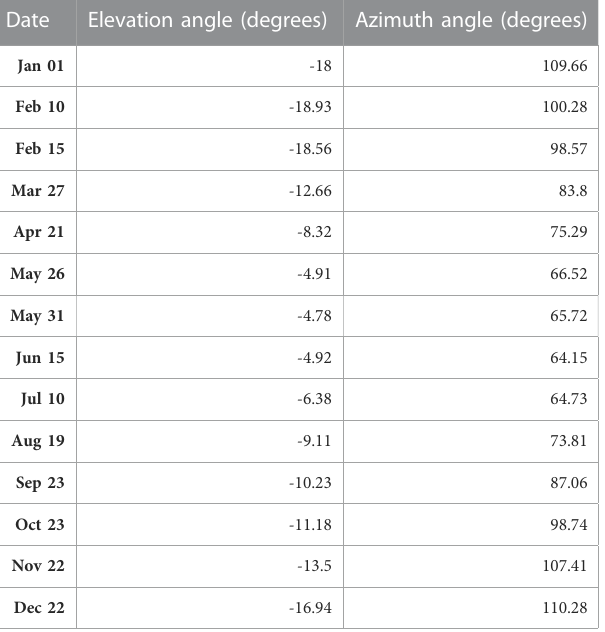
TABLE 1 Solar altitude and heat consumption at the study